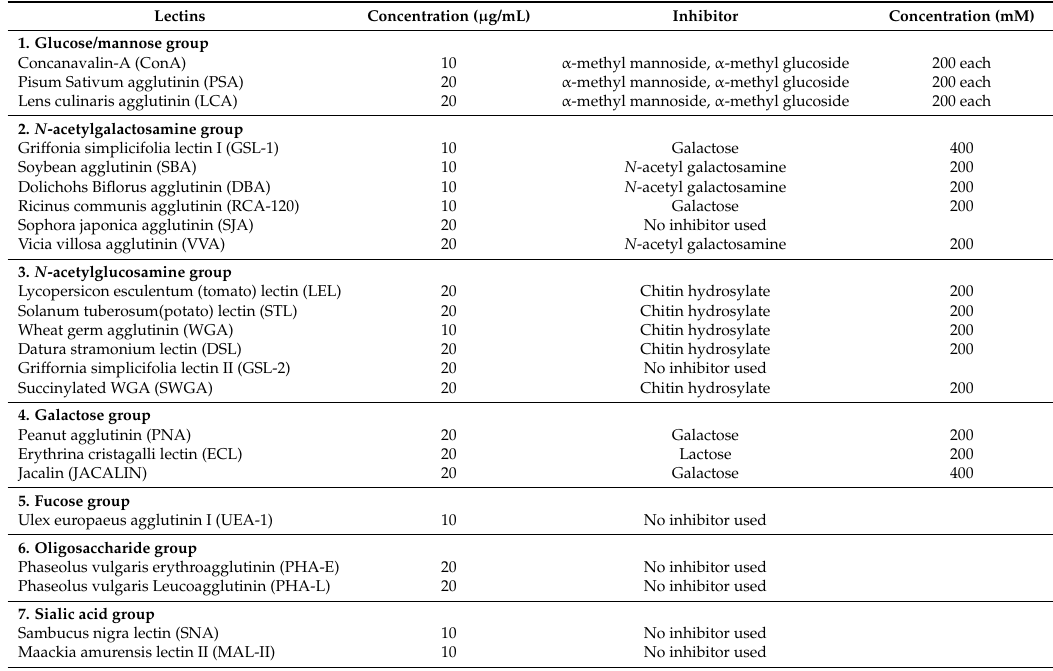
Table 1. Lectins and inhibitors used for determining the lectin binding profile of MK1-OSU cells.